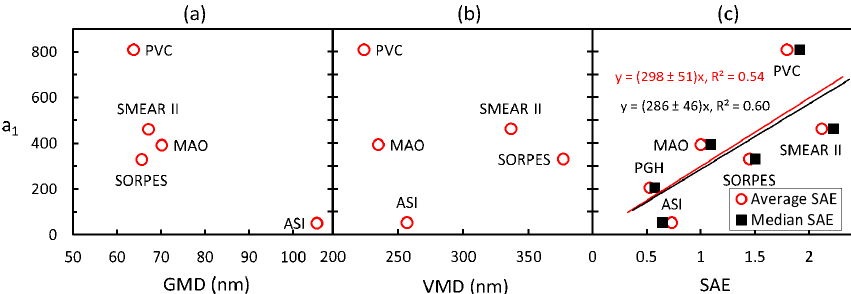
Figure 7. Relationship of the a 1 coefficient in Eq. (8) with the average (a) geometric mean diameter of the PNSD data size ranges of the sites, (b) volume mean diameter of the same size range, and (c) PM 10 scattering Ångström exponent (SAE).